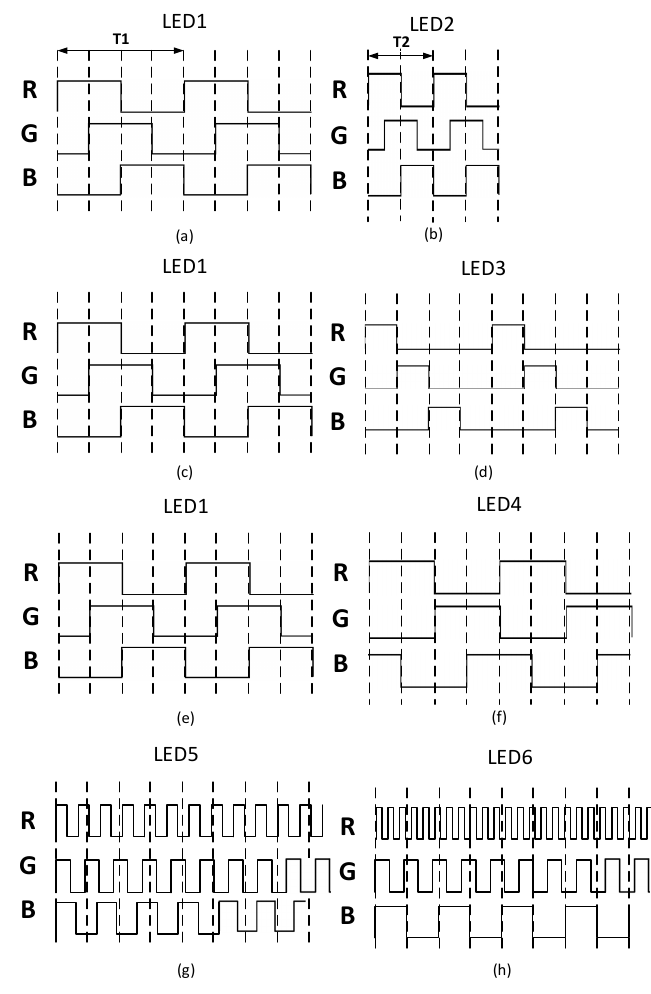
Figure 6. The modulated scheme. (a)~(h) corresponds to the modulation sequence of LED1~LED6